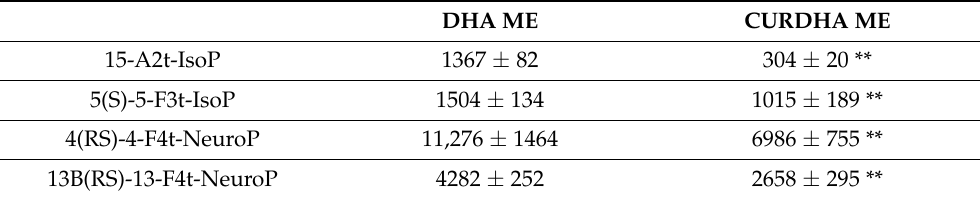
Table 2. Oxylipin levels (pg/2 mg DHA) in DHA and CUR-DHA loaded microemulsions stored 3 months at 4 ◦ C under